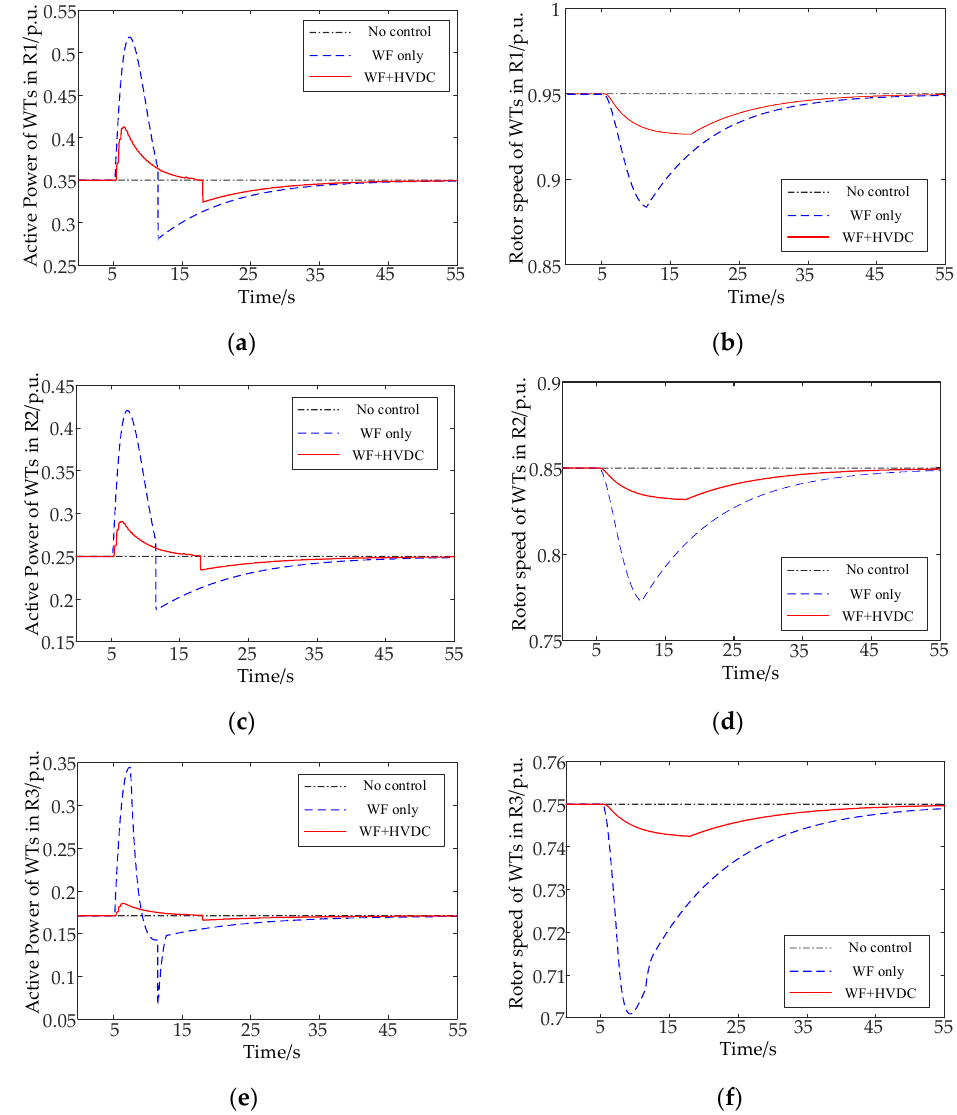
Figure 15. Simulation results under low wind power permeability and low wind speed condition. ( a ) Sending-end system frequency, ( b ) active power of WF, and ( c ) active power of HVDC, ( d ) fre- quency response output of sending-end system.